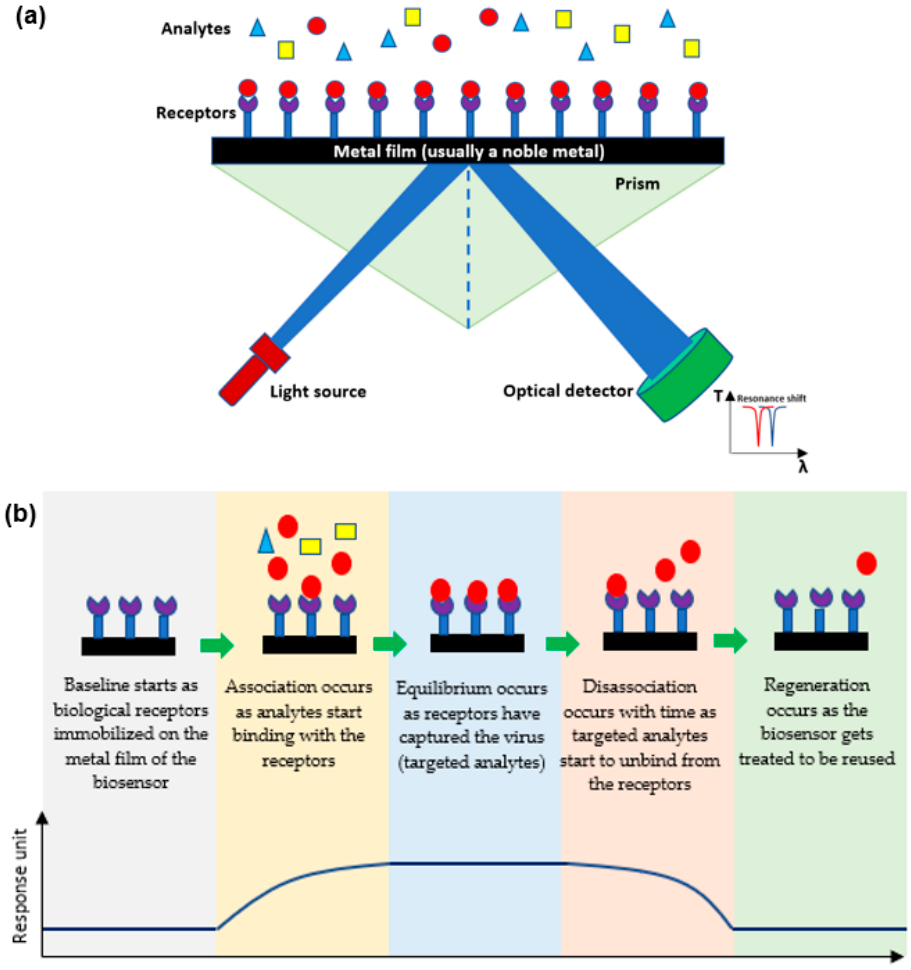
Figure 2. ( a ) A schematic diagram of the mechanism of plasmonic optical biosensors, and ( b ) Stages of SPR sensor from detecting analytes to detaching to be reused. of SPR sensor from detecting analytes to detaching to be